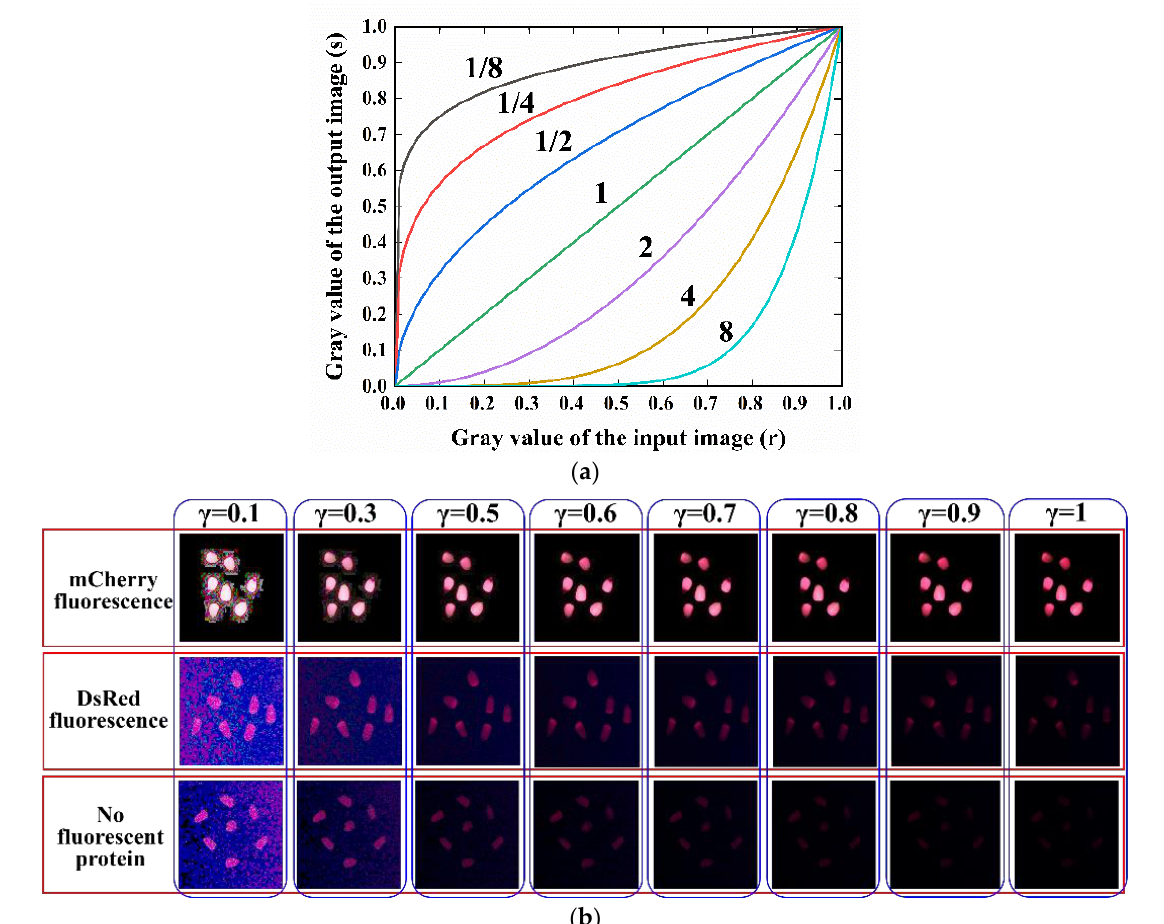
Figure 7. Maize kernel image enhancement with gamma transformation: ( a ) gamma transformation image grey-scale input – output relationship, and ( b ) results of gamma transformation.